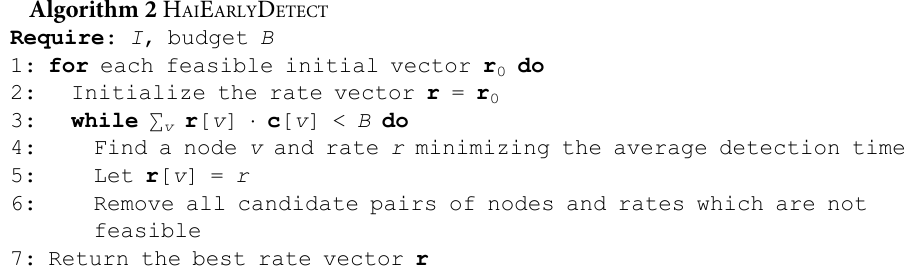
Algorithm 2 H AI E ARLY D